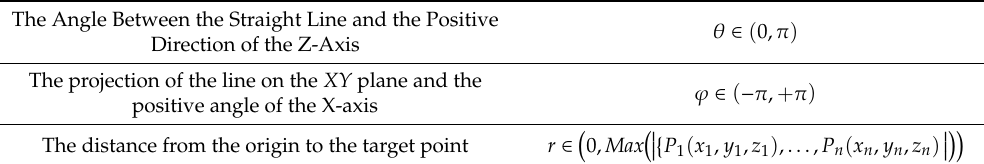
Table 2. Restrictions of